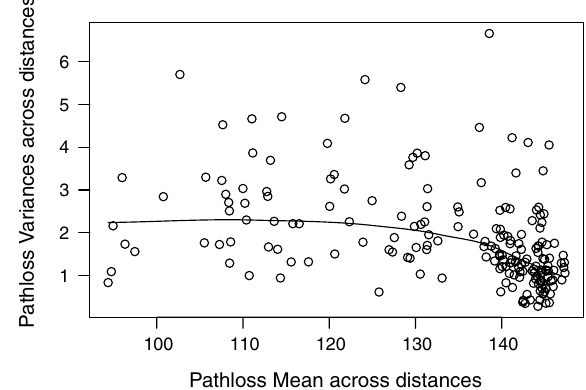
Fig. 2 Mean–variance relationship of path loss measurements across